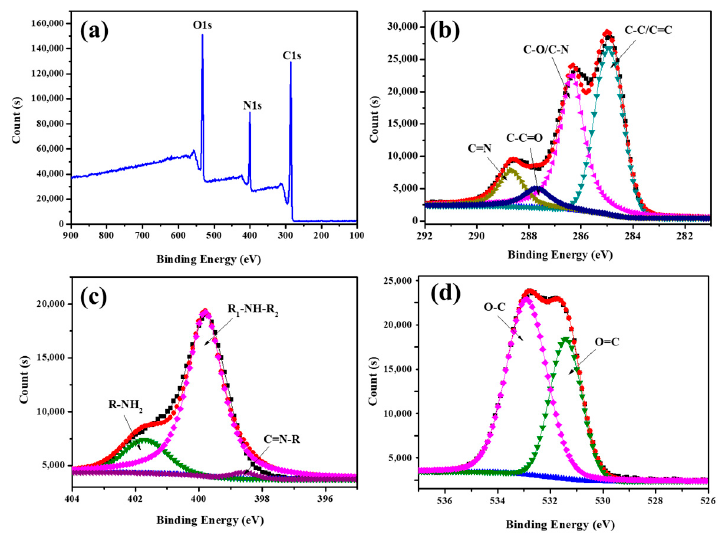
Figure 3. ( a ) XPS survey spectrum of FA-PDA FONs and high-resolution XPS spectra of ( b ) C1s peaks, ( c ) N1s peaks, and ( d ) O1s peaks,